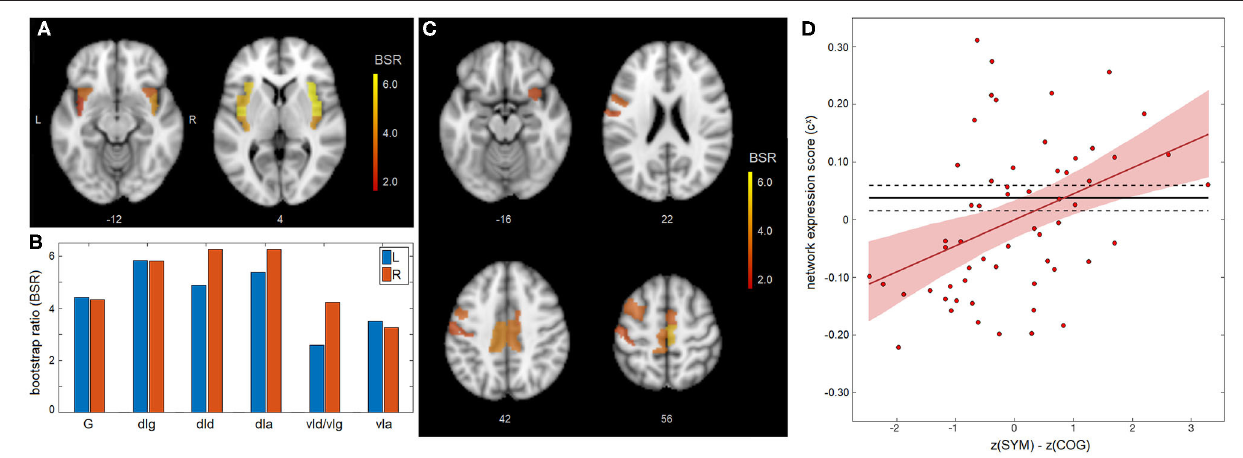
FIGURE 2 | Appraisal mismatch and insular connectivity for the concussed group. (A,B) For the insular subnetwork, salience bootstrap ratios (BSRs) are shown as a spatial map and as barplot values, ordered posterior-to-anterior. (C) For the full-brain subnetwork, salience BSRs are also shown as a spatial map. (D) Network expression scores, reflecting insular connectivity to the identified whole-brain network, are plotted against mismatch scores z(SYM)-z(COG) for individual control athletes. The regression line of best fit is plotted (solid red line), along with its 95%CI (shaded area). The control mean is also plotted (solid black line), along with the 95%CI of the mean (dashed lines). Insular subregions include: hypergranular (G), dorsal granular (dIg), dorsal dysgranular (dId), dorsal agranular (dIa) ventral dysgranular/granular (vId/vIg), and ventral agranular